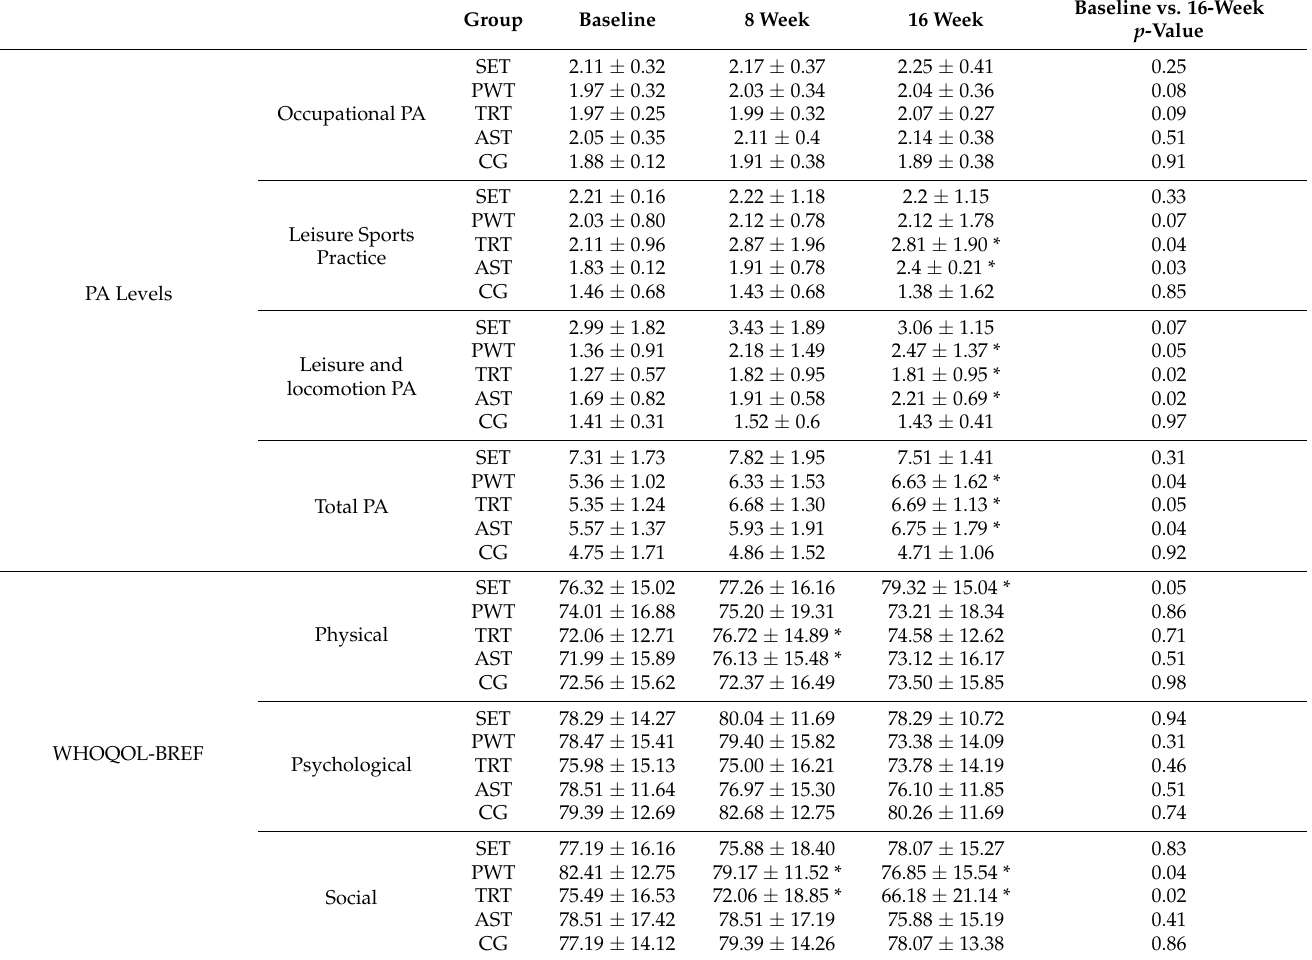
Table 3. RT-type effects in PA and QoL.